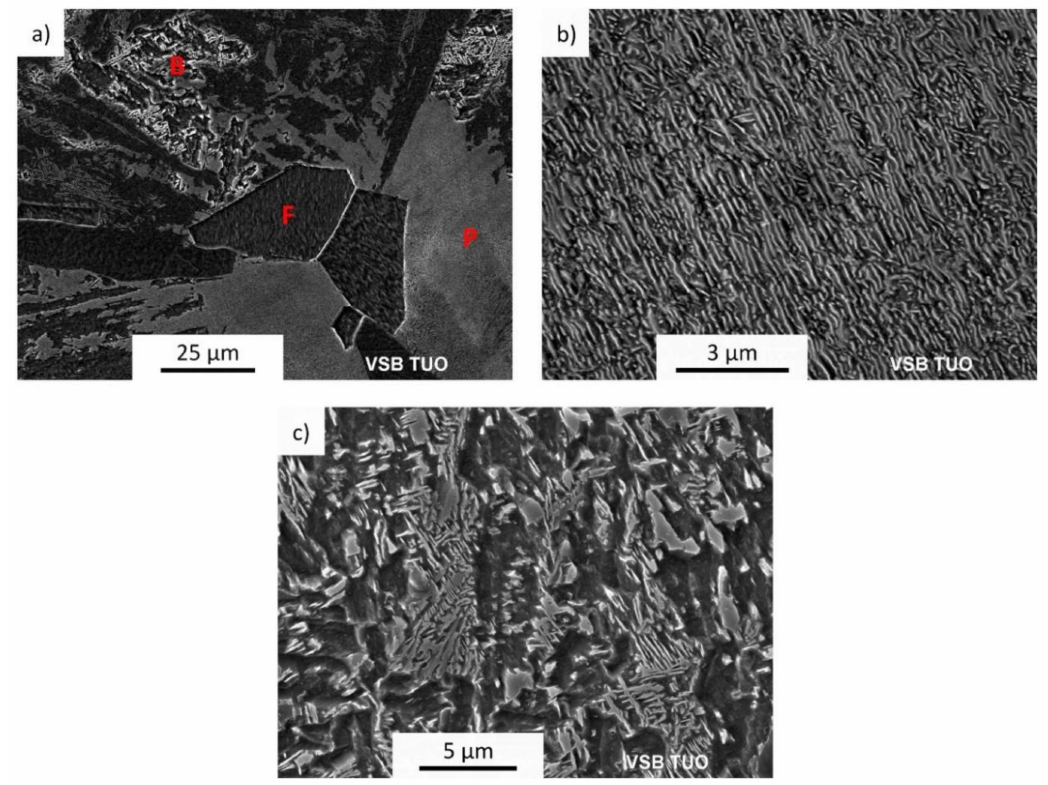
Figure 2. Initial microstructure—scanning electron microscopy (SEM) analysis. ( a ) Region of the prior austenitic grain boundary with ferrite ( F ), pearlite ( P ) and bainite ( B ); ( b ) pearlite detail; ( c ) bainite